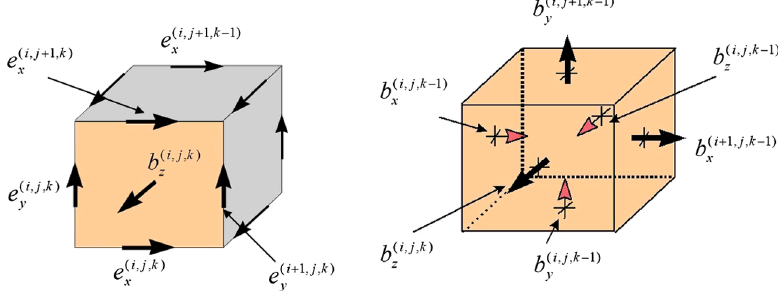
FIG. 3. One cell of cell complex G showing the positions of the voltage and magnetic flux